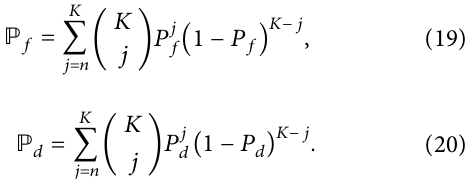
Table 1: Statistical properties of Y